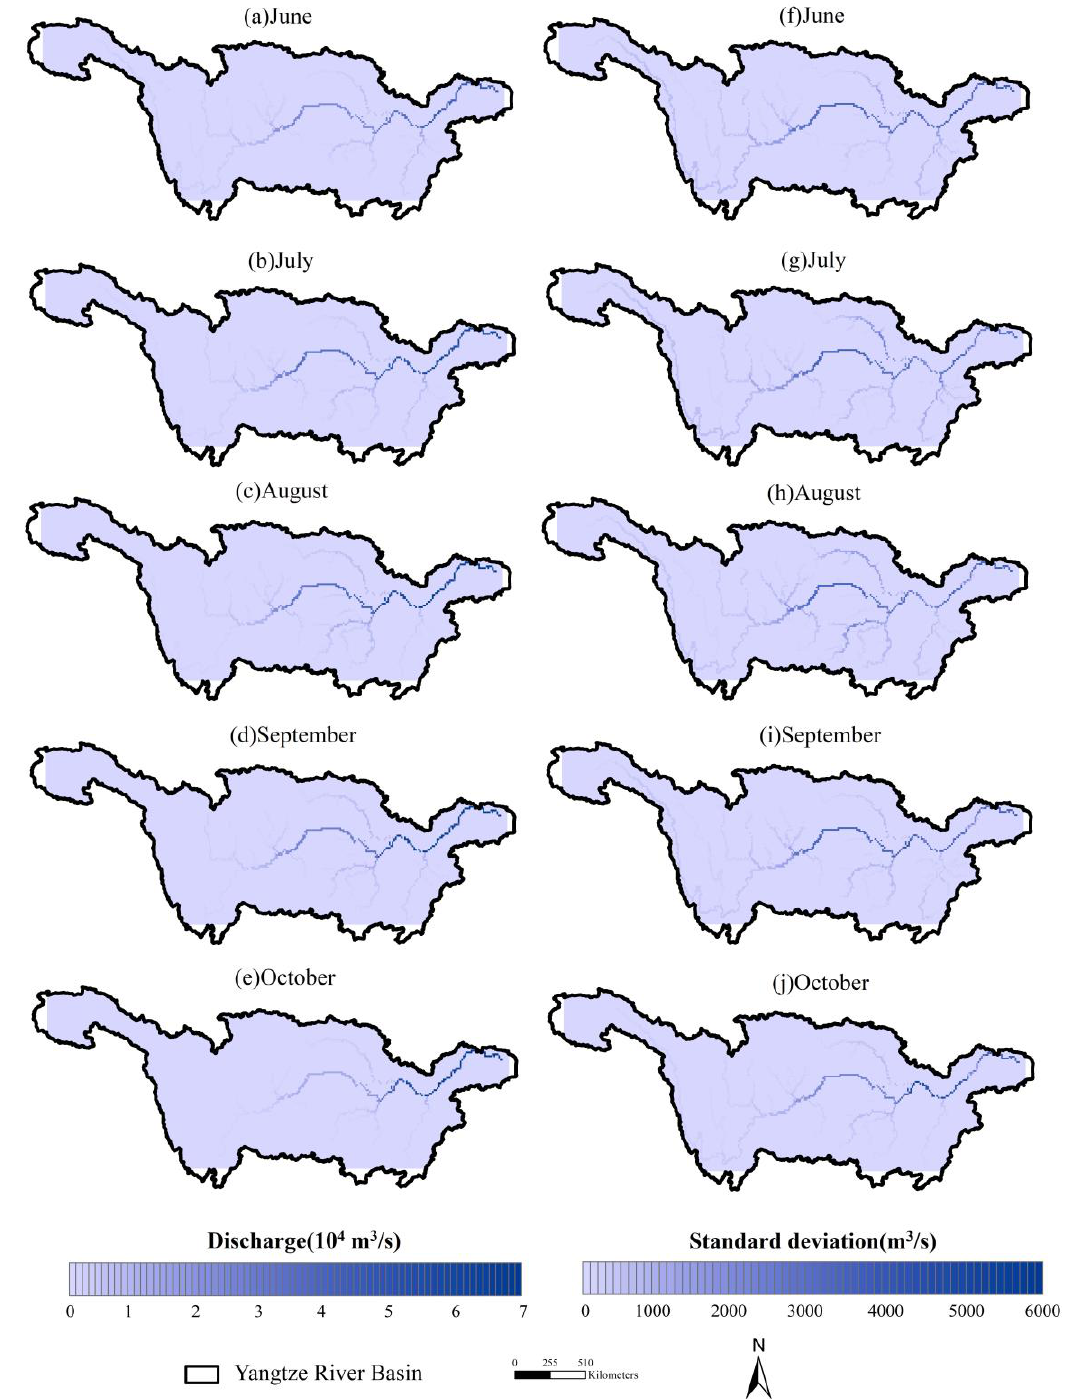
Figure 9. Monthly spatial distribution of ensemble means of discharge ( left panel) and their standard deviation ( right panel) in the Yangtze River basin from June 2020 to October 2020.